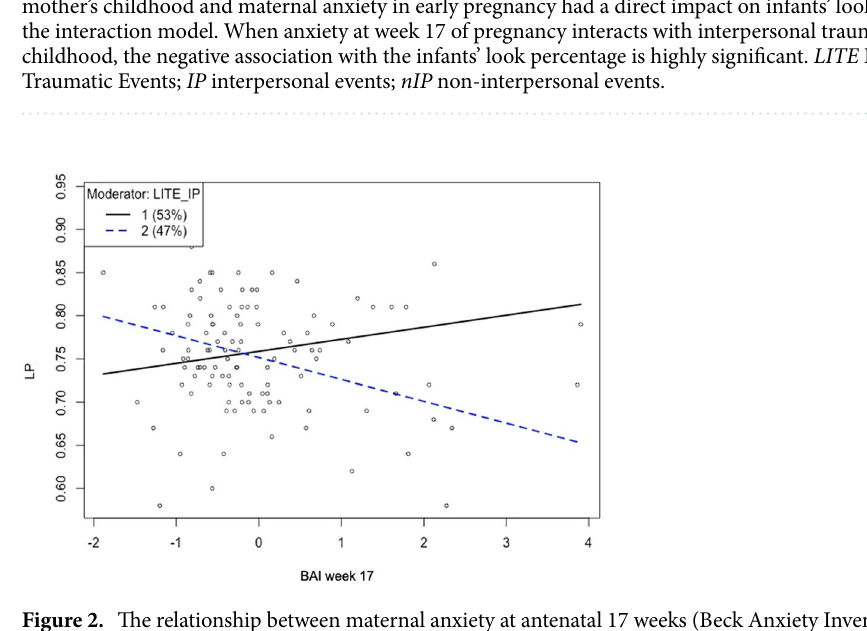
Figure 2. The relationship between maternal anxiety at antenatal 17 weeks (Beck Anxiety Inventory, BAI week 17) and infant’s focused attention (look percentage, LP), is moderated by the level of interpersonal traumatic events (IP) in mother’s childhood measured by Life Incidence of Traumatic Events (LITE). Level 1 (solid line) represents mothers who exposed to less trauma in childhood compared to those at level 2 (dotted